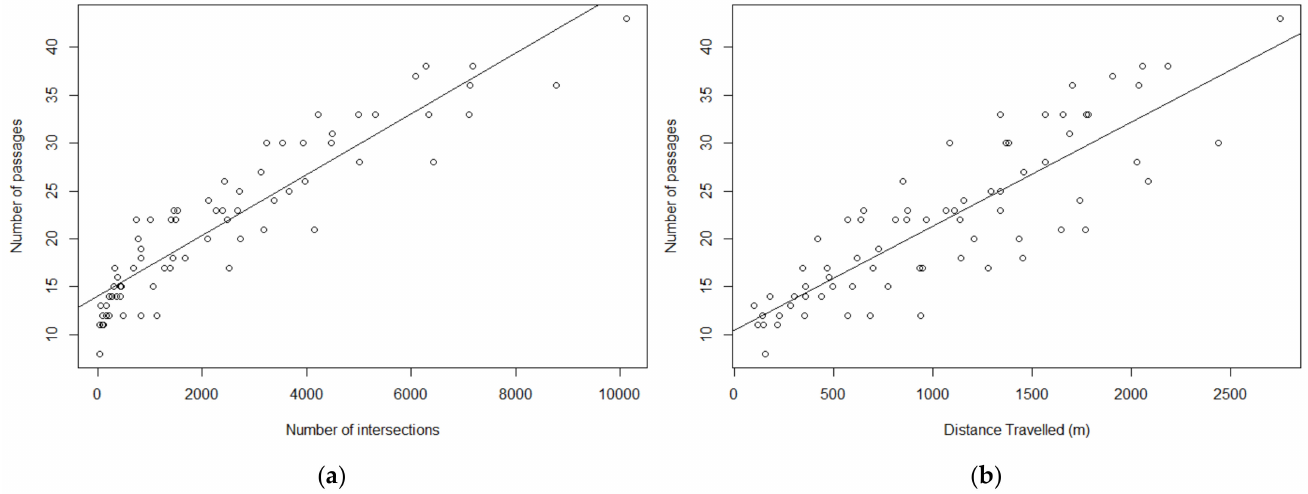
Figure 4. Positive correlation plots between number of passages and other studied parameters: ( a ) Correlation plot showing positive correlation between number of passages and number of in- tersections. ( b ) Correlation plot showing positive correlation between number of passages and distance